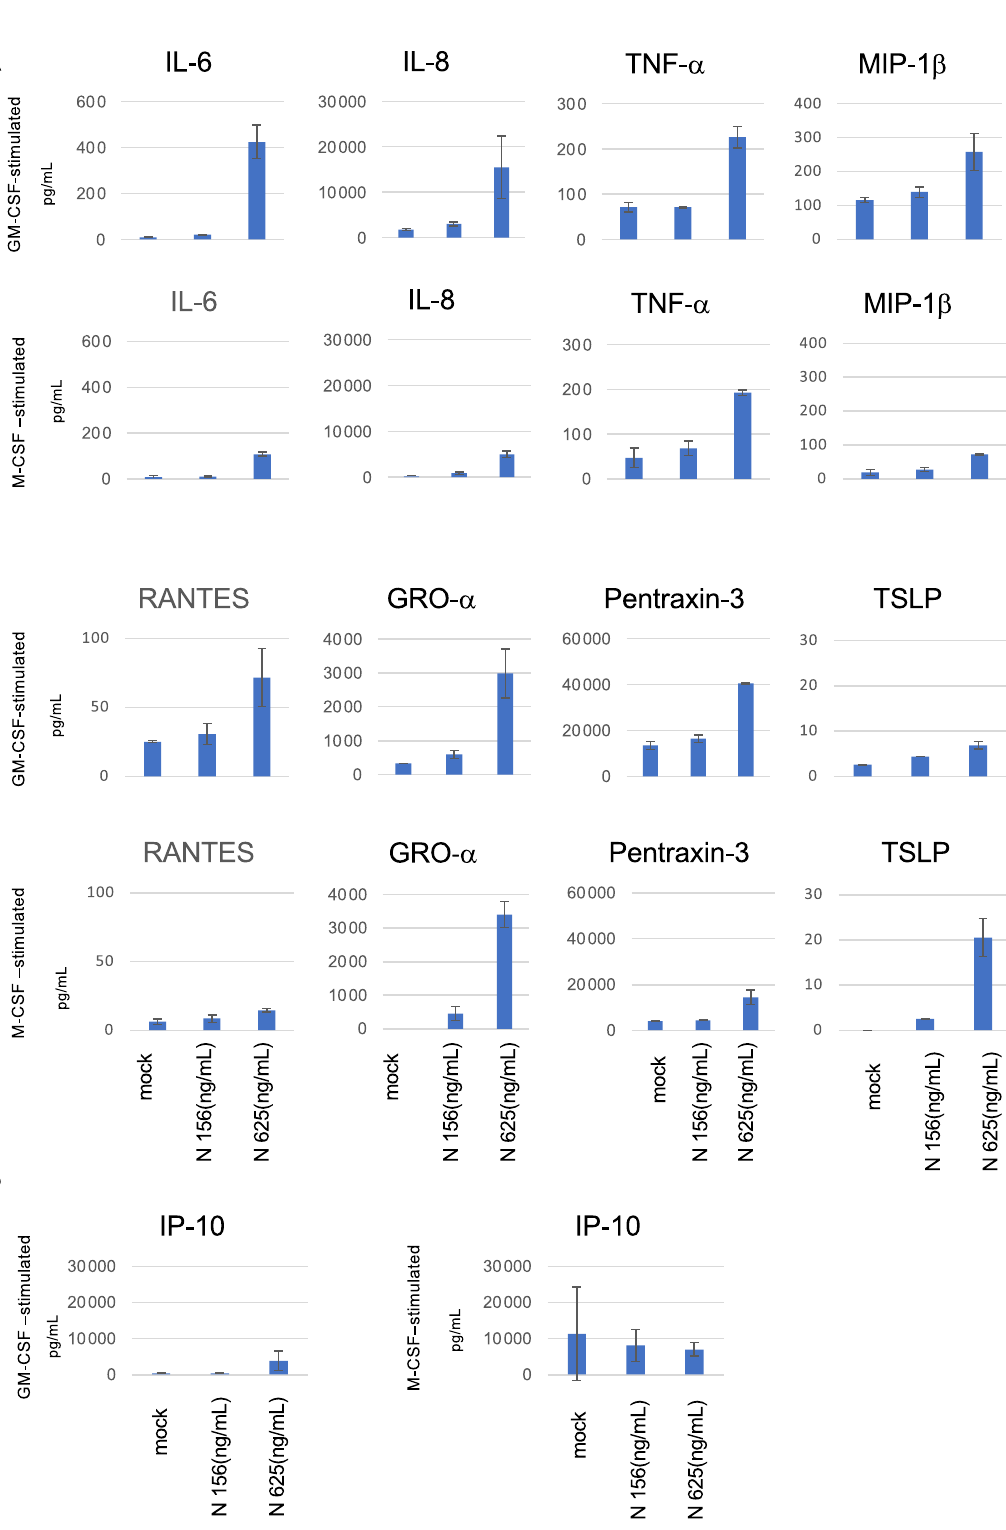
Figure 3. Profiles of cytokine production from macrophages (MDM) stimulated by N protein. MDM differentiated with GM-CSF or M-CSF were stimulated by 156 or 625 ng/mL of N proteins for 2 days. The cytokine levels were measured by a multiplex assay, as described in the Methods. Data are expressed as the mean and standard deviation of triplicate